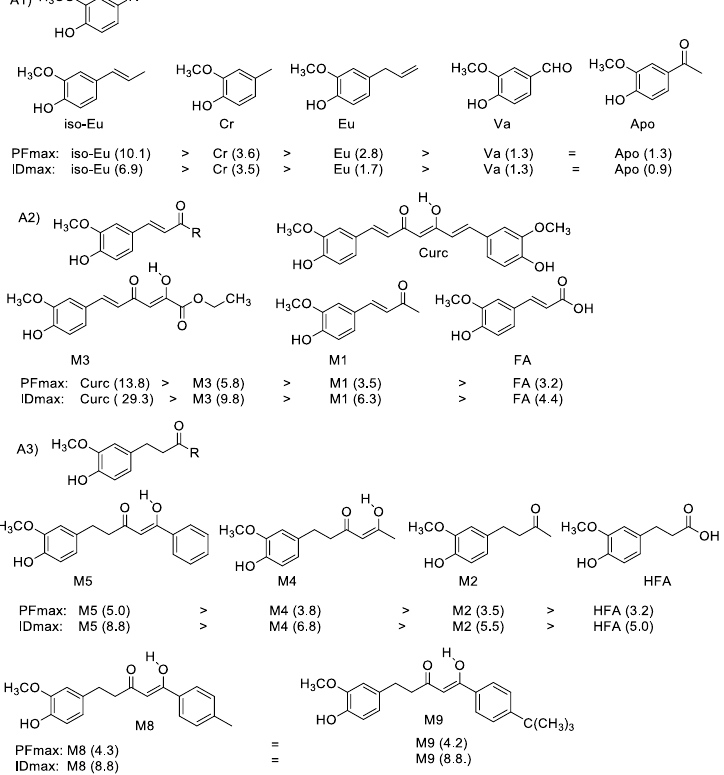
Figure 1. Effect of the substituents in the side chain of selected A1 – A3 ortho -methoxyphenols expressed in terms of PF and ID values.